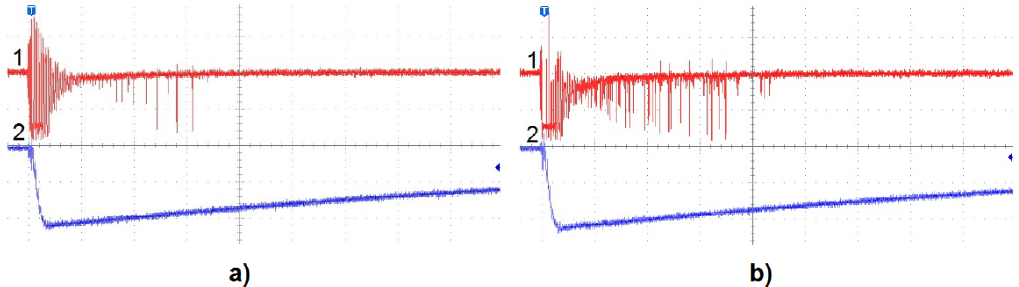
Figure 7. Light and voltage waveforms recorded at LI of negative polarity, t = 4 µs/div., V = 50 kV/div., 1—light, 2—voltage, V = 115 kV: ( a ) mineral oil, ( b ) synthetic ester.